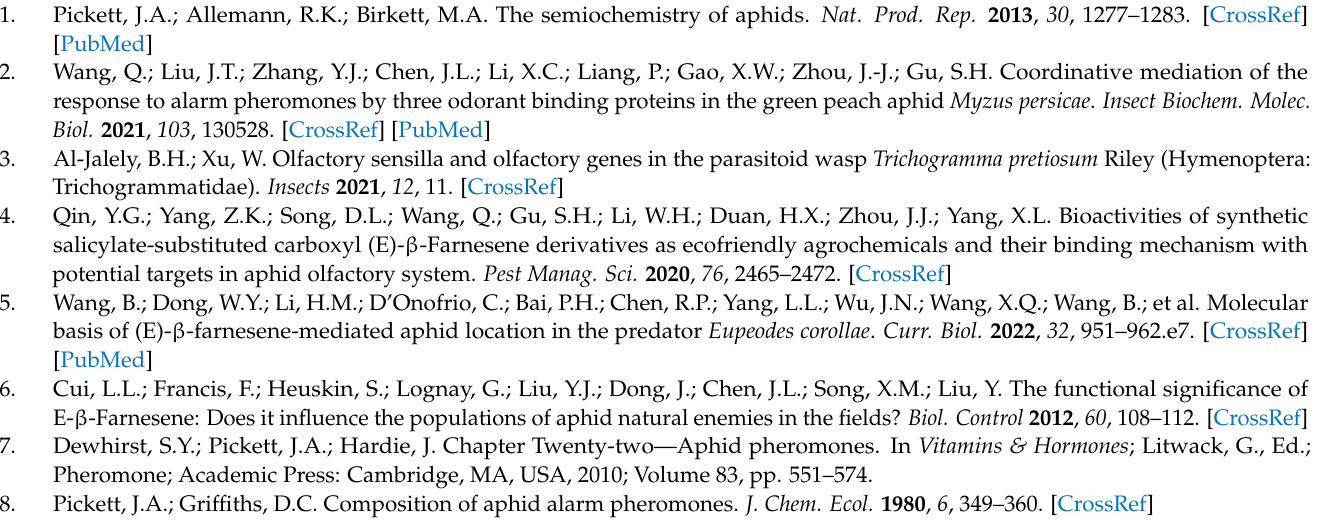
Figure S2: 1 H NMR spectra of E β F Analog I; Figure S3: 13 C NMR spectra of E β F Analog I; Figure S4: HRMS spectra of E β F Analog I; Figure S5: 1 H NMR spectra of E β F Analog II; Figure S6: 13 C